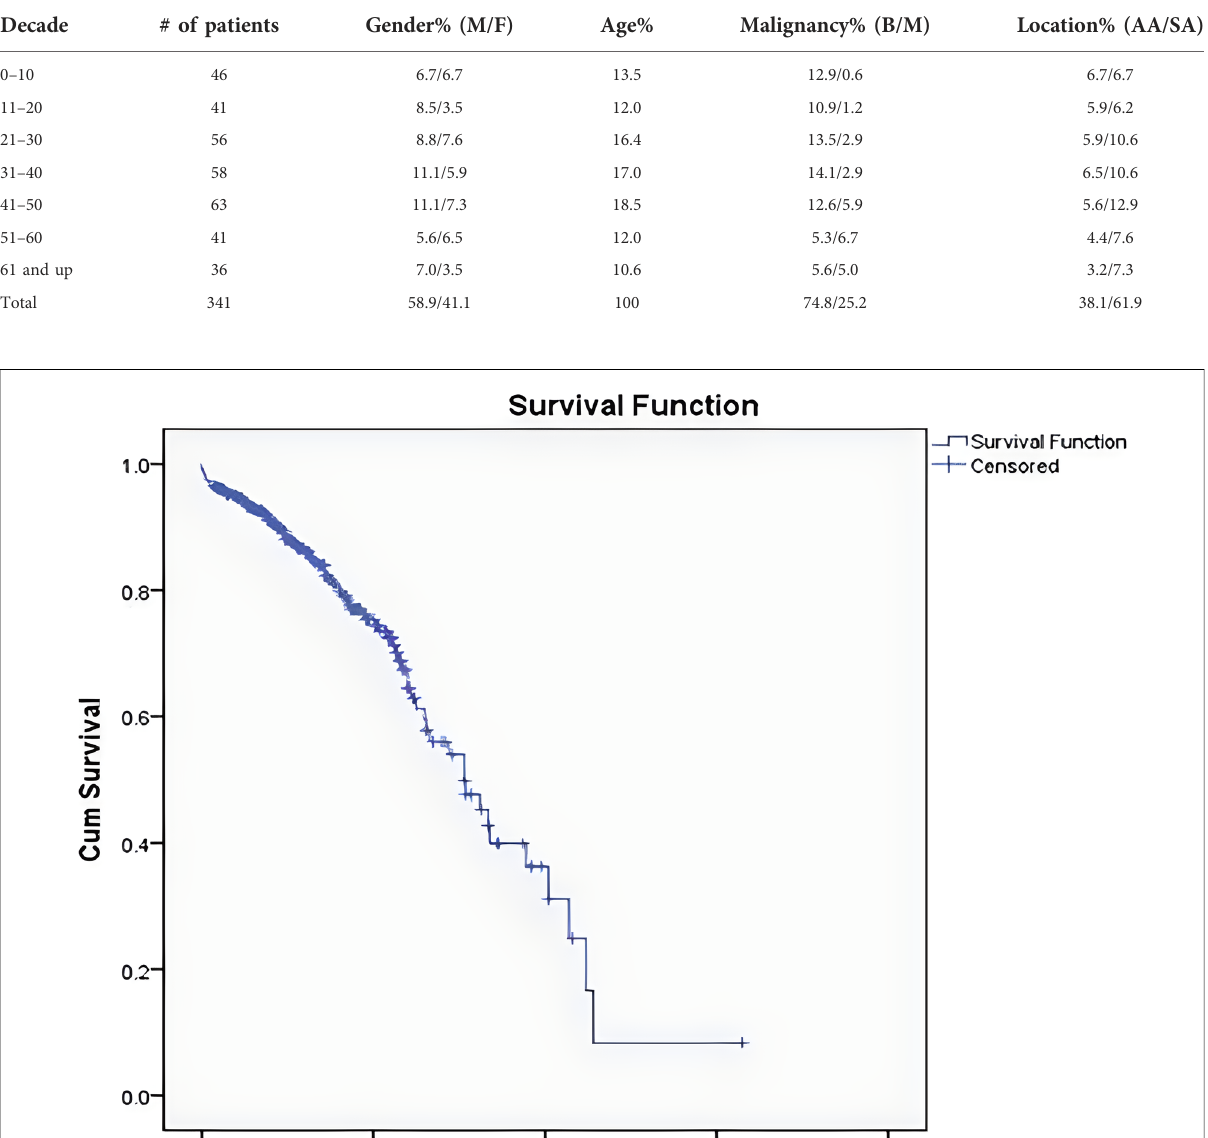
TABLE 2 Sex, benign and malignant tumors, and tumor locations in different age groups.